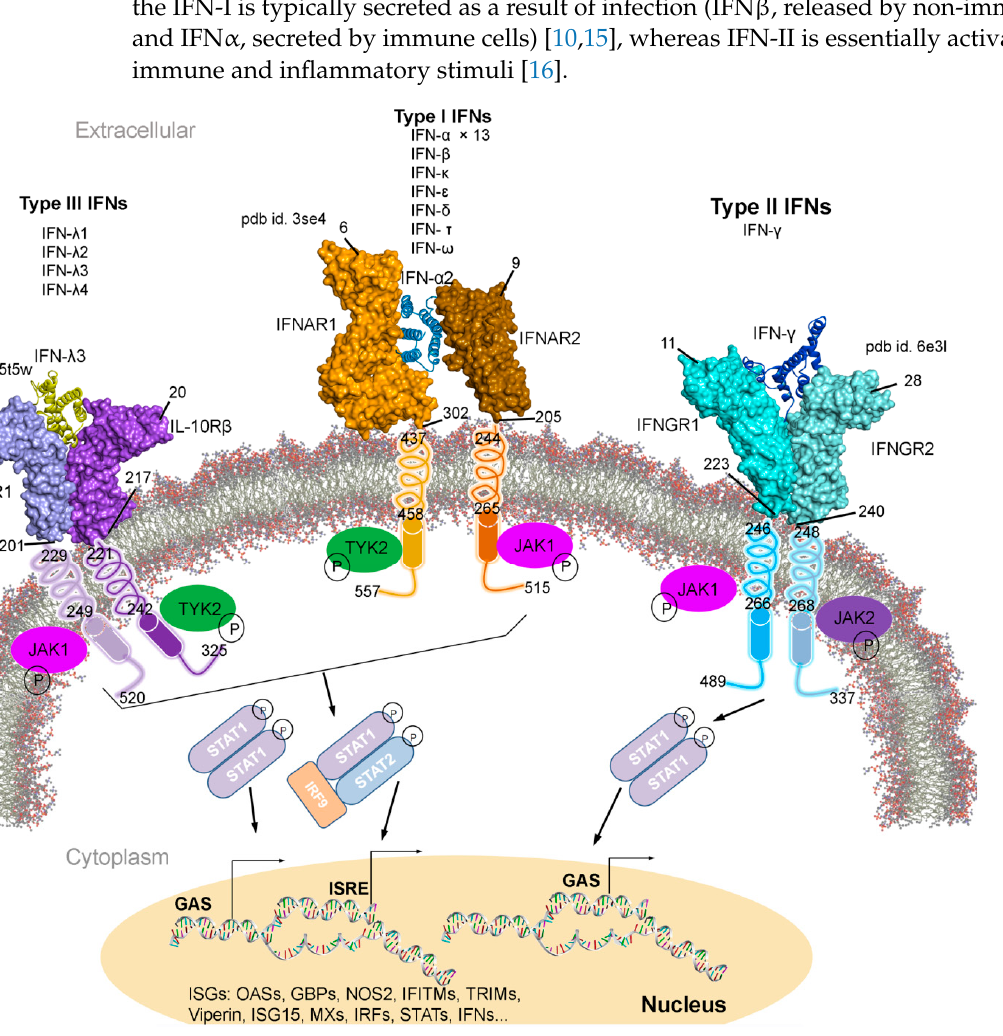
Figure 1. Type I, II, and III interferons (IFNs) signalling cascades, along with their tertiary structures retrieved from the Protein data bank (PDB) [7] database. Individual IFN receptors from the IFNAR1-IFN α 2-IFNAR2 (pdb id. 3se4 [17]), IFNGR1-IFN γ -IFNGR2 (pdb id. 6e3l [18]), and IFNLR1-IFN λ 3-IL10R β (pdb id. 5t5w [19]) complexes containing the ex- tracellular topological domain (ETD), transmembrane domain (TMD) and cytoplasmic domain (CPD) are described with their amino acid range. Type I, II and III IFNs signal via distinct receptors IFNAR (composed of IFNAR1 and IFNAR2), IFNGR (IFNGR1 and IFNGR2) and IFNLR (INFLR1 and IL-10R β ), respectively [20,21]. Upon the IFN binding to the re-